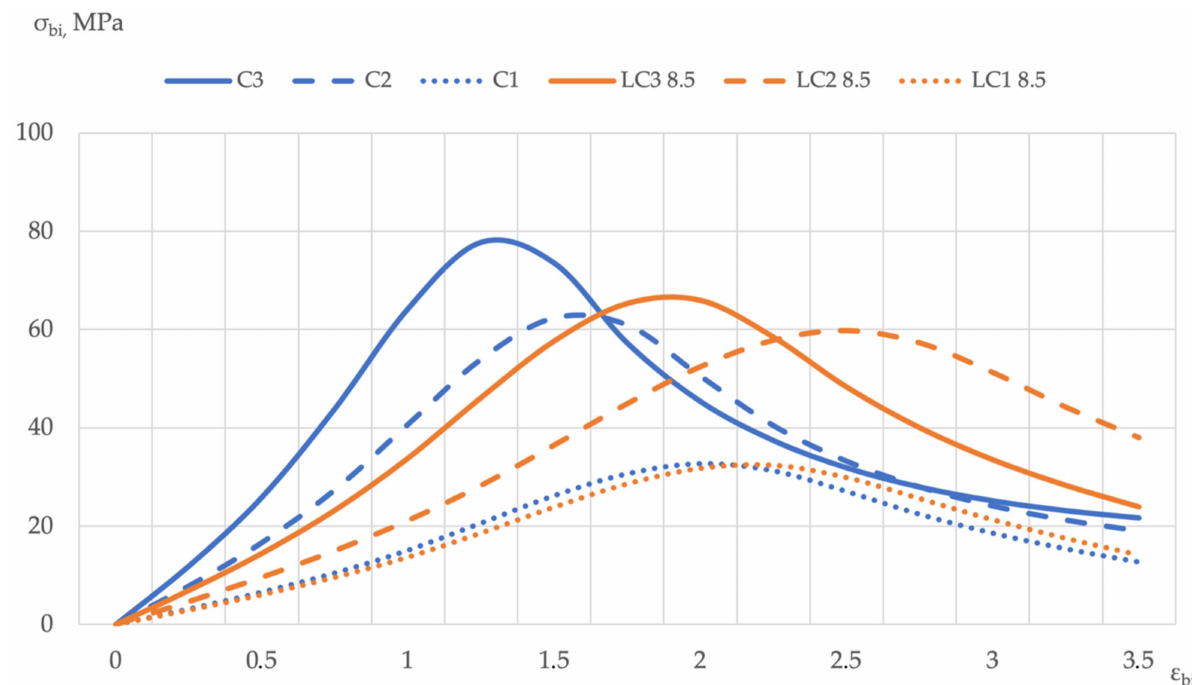
Figure 10. Diagram of “stress—strain” under compression for the differential characteristics of vibro-centrifuged concrete (C1, C2, C3—respectively the inner, middle, and outer layer of the control concrete composition; LC1 8.5, LC2 8.5, LC3 8.5—respectively the inner, middle, and outer layer lightweight concrete on activated water with pH = 8.5).